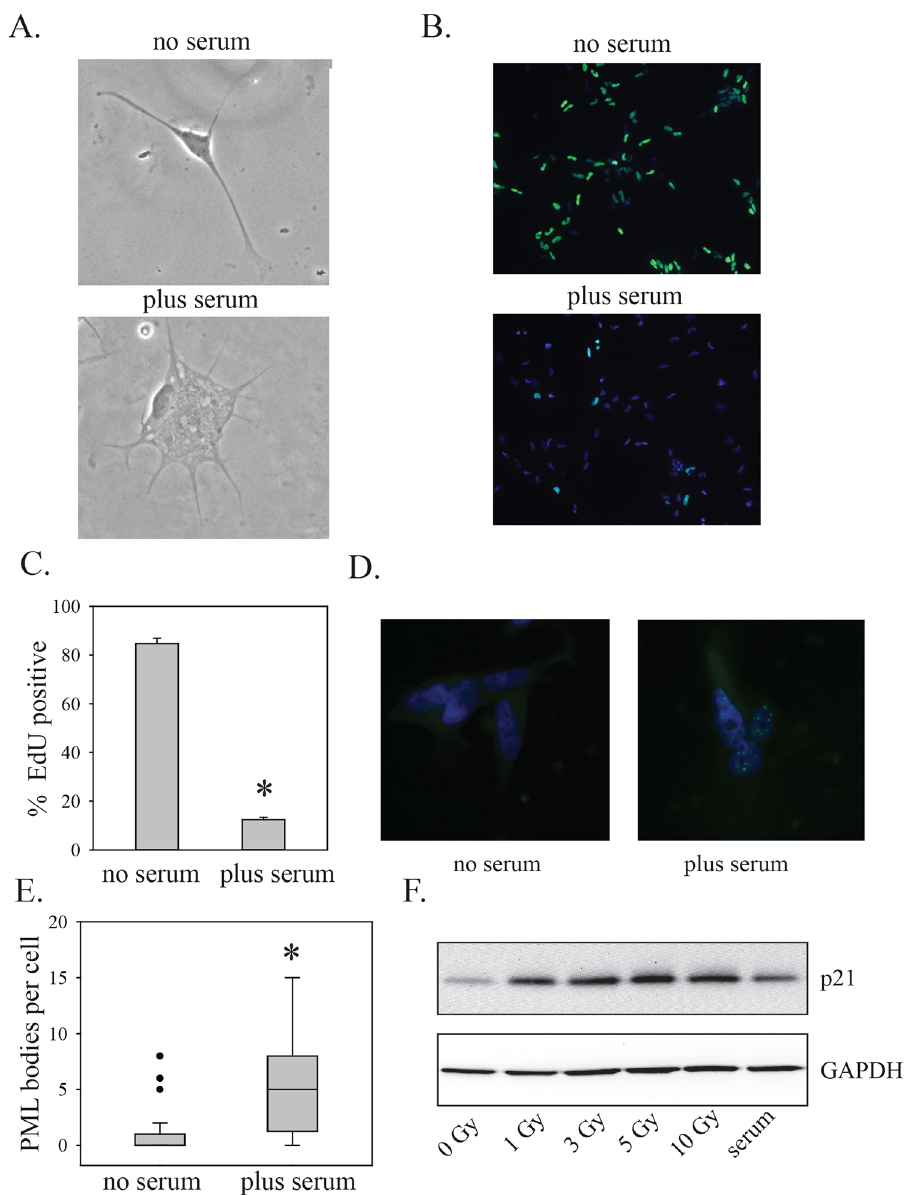
Figure 2. Characterization of senescence induction by serum. ( A ) PriGO8A cells were treated without or with serum for seven days. Cells were then fixed and stained for SA β gal activity. Images shown are representative phase contrast images of SA β gal-cells (photographed in black and white). ( B ) PriGO8A cells were treated as in ( A ). On day 7, they were labelled for 24 h with EdU. Cells with EdU incorporation were detected as described in Materials and Methods and nuclei were stained with DAPI. ( C ) Quantitation of EdU incorporation. Data are from five randomly chosen fields. ( D ) PriGO8A cells were treated as in ( A ), fixed and analyzed for PML bodies by immunofluorescence. Representative images are shown with PML in green and DAPI staining in blue. ( E ) Quantitation of PML immunofluorescence. Data are from 100 cells per condition. Whiskers show 10 th and 90 th percentiles. Statistical significance was determined using the Mann-Whitney Rank Sum test. * Indicates p < 0.05. ( F ) PriGO8A cells were treated with the indicated doses of radiation or 10% serum. Two days later, total cell extracts were analyzed by Western blotting for levels of p21. GAPDH was used as a loading